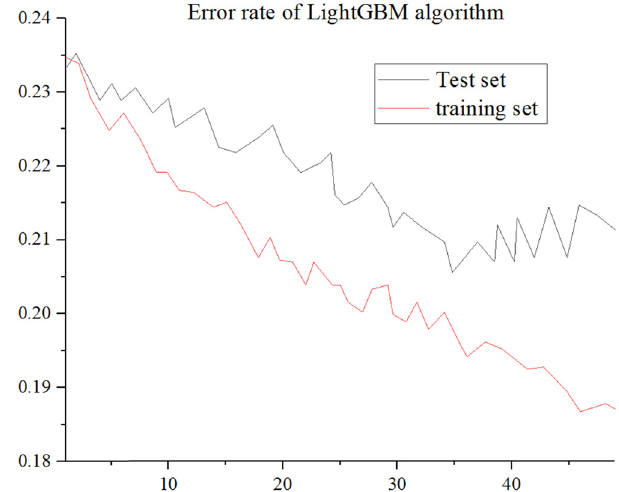
Figure 3: Error rate of LightGBM algorithm.